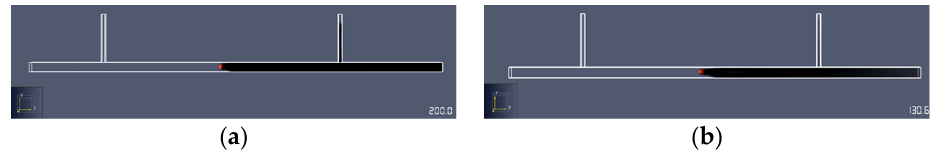
Figure 6. Flue gas diffusion diagrams at 3.6 m/s under different fire scales (the ventilation velocity of the transverse passageway was 3 m/s): ( a ) 5 MW; ( b ) 20 MW.